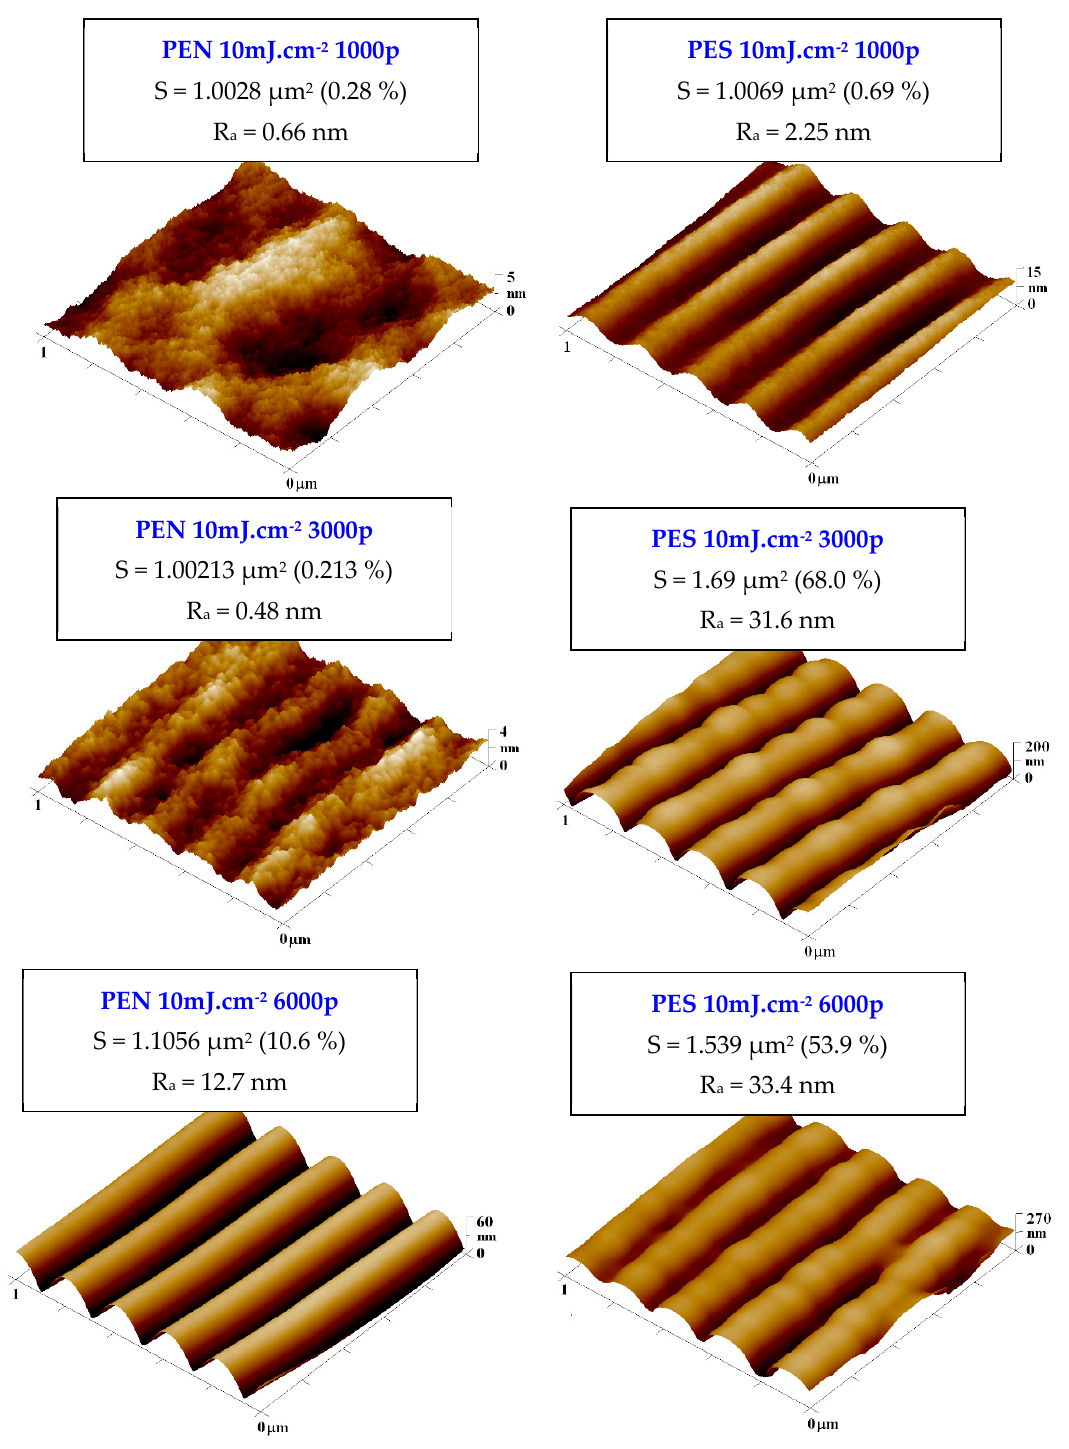
Figure 4. Atomic force microscopy images of PEN and PES foils treated by KrF laser with the laser fluence of 10 mJ · cm − 2 and 1000, 3000, and 6000 pulses. The Ra represents average surface roughness and S the effective surface area.